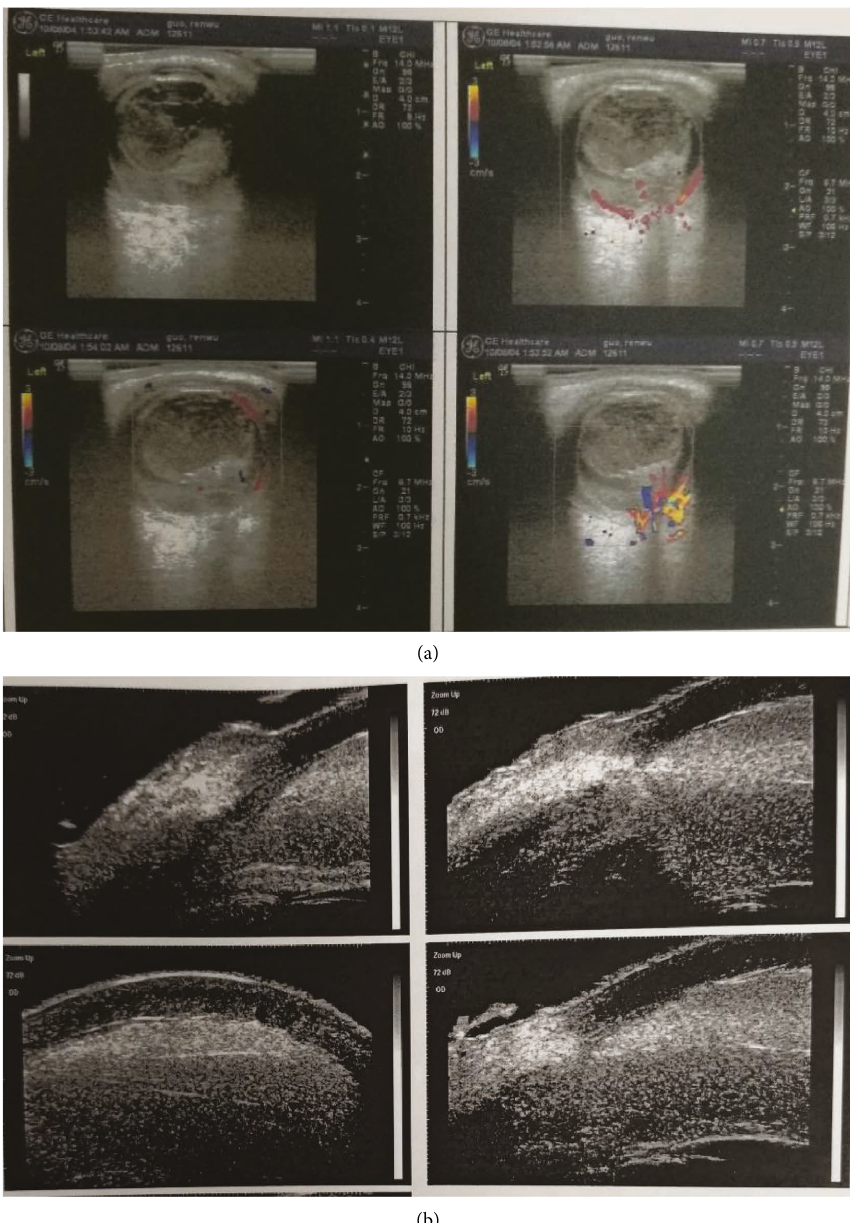
Figure 1: (a): Color Doppler ultrasonography of a patient exhibiting vitreous fibroplasia and choroidal and retinal detachment 3 days after repair of the globe. (b): Ultrasound biomicroscopy of a patient showing fibroplasia in the anterior